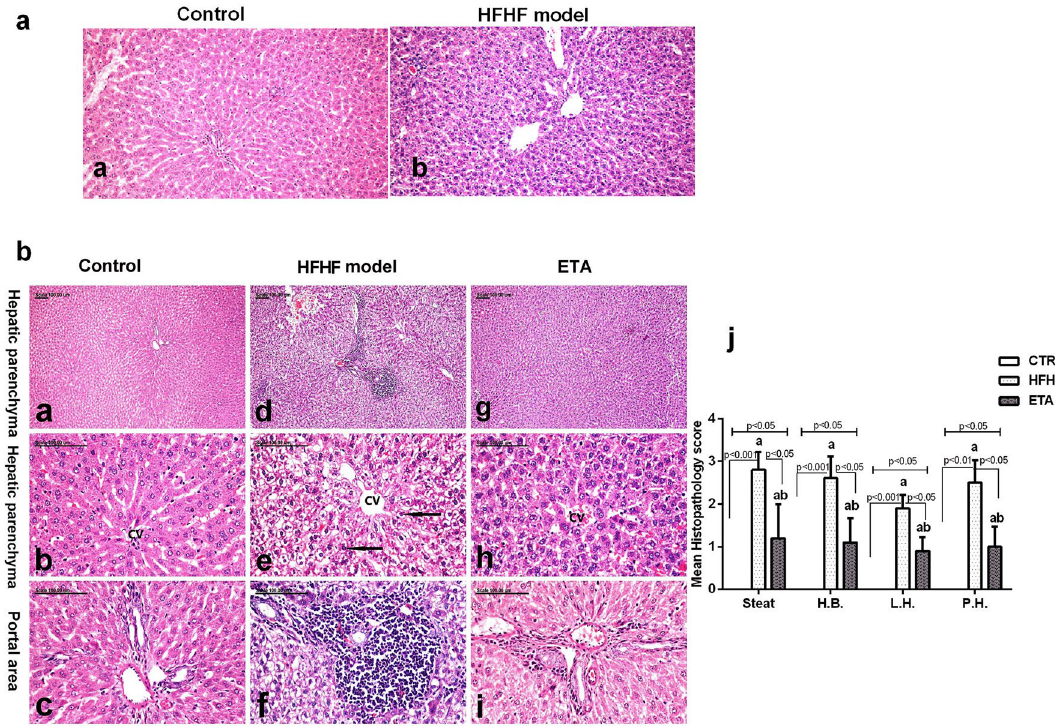
Figure 7. Histopathological changes in the hepatic tissues of rats using light microscopy. The photomicrographs show the following groups: In panel ( a ); The liver of normal control rats showed a standard histological structure with normal hepatocytes ( a ). The liver of HFHF-fed rats showed diffuse vacuolar degeneration of the hepatocytes which appeared greatly swollen ( b ). In panel ( b ); the normal control group ( a – c ) shows well-preserved hepatic parenchyma ( a ) with normal hepatocytes ( b ) and normal portal area ( c ), whereas the HFHF group ( d – f ) shows diffuse and extensive vacuolization of hepatocellular cytoplasm ( d ), with substantial swelling and ballooning of hepatocytes with fat globules and eccentric nuclei position ( e ) and intense infiltration of portal areas with mononuclear cells ( f ). The ETA-treated group ( g – i ) shows a marked reduction of hepatocellular swelling ( g and h , respectively) and minimal infiltration of the portal area with few mononuclear cells ( i ). H&E stain; magnification, ×40; scale bar = 100 µm. ( j ) Mean pathological score recorded in all groups. Data are presented in the mean ± SD values and are representative of a single independent experiment ( n = 6). Statistical analysis was performed using the Kruskal–Walli’s test, followed by Dunn’s post hoc test. a